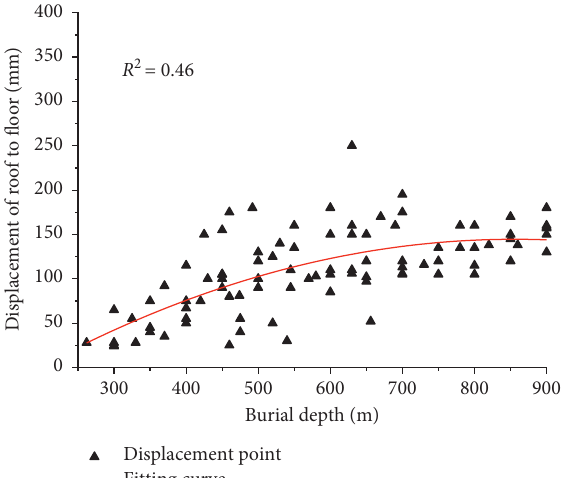
Figure 4: Displacement of roof to floor (35 th